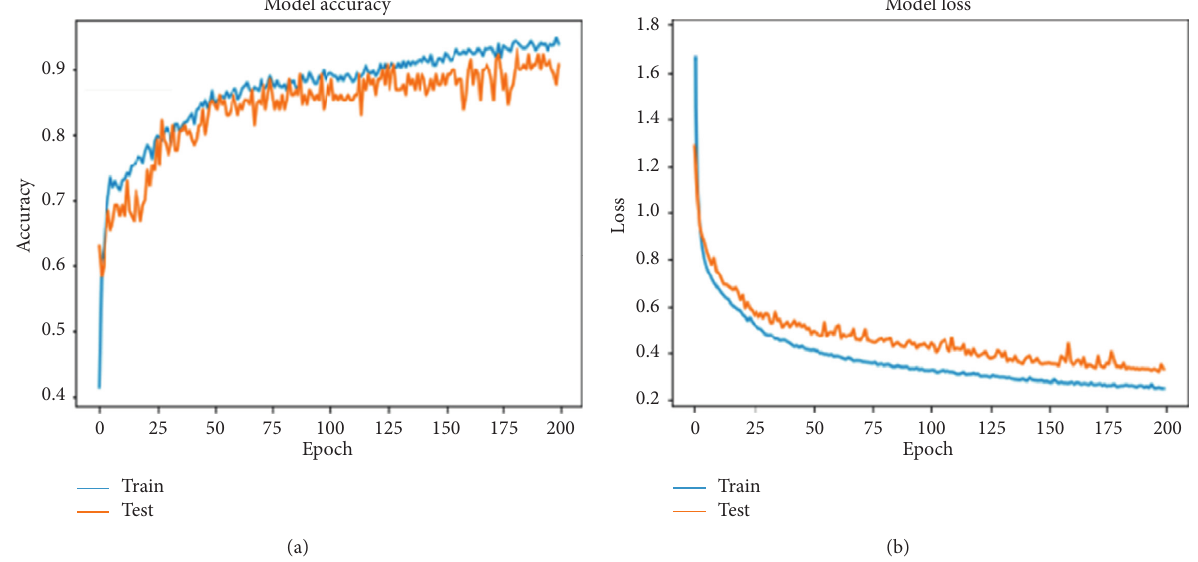
Figure 12: Model accuracy and model loss for M-learning model 1. (a) Model 1 accuracy. (b) Model 1 loss.